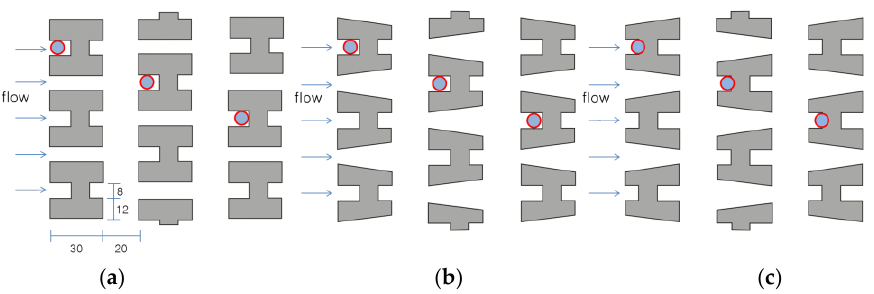
Figure 1. Three different geometries (type 1: rectangle ( a ), type 2: right turn trapezoid ( b ), and type 3: left turn trapezoid ( c )) for capturing a breast cancer cell line (MCF-7).